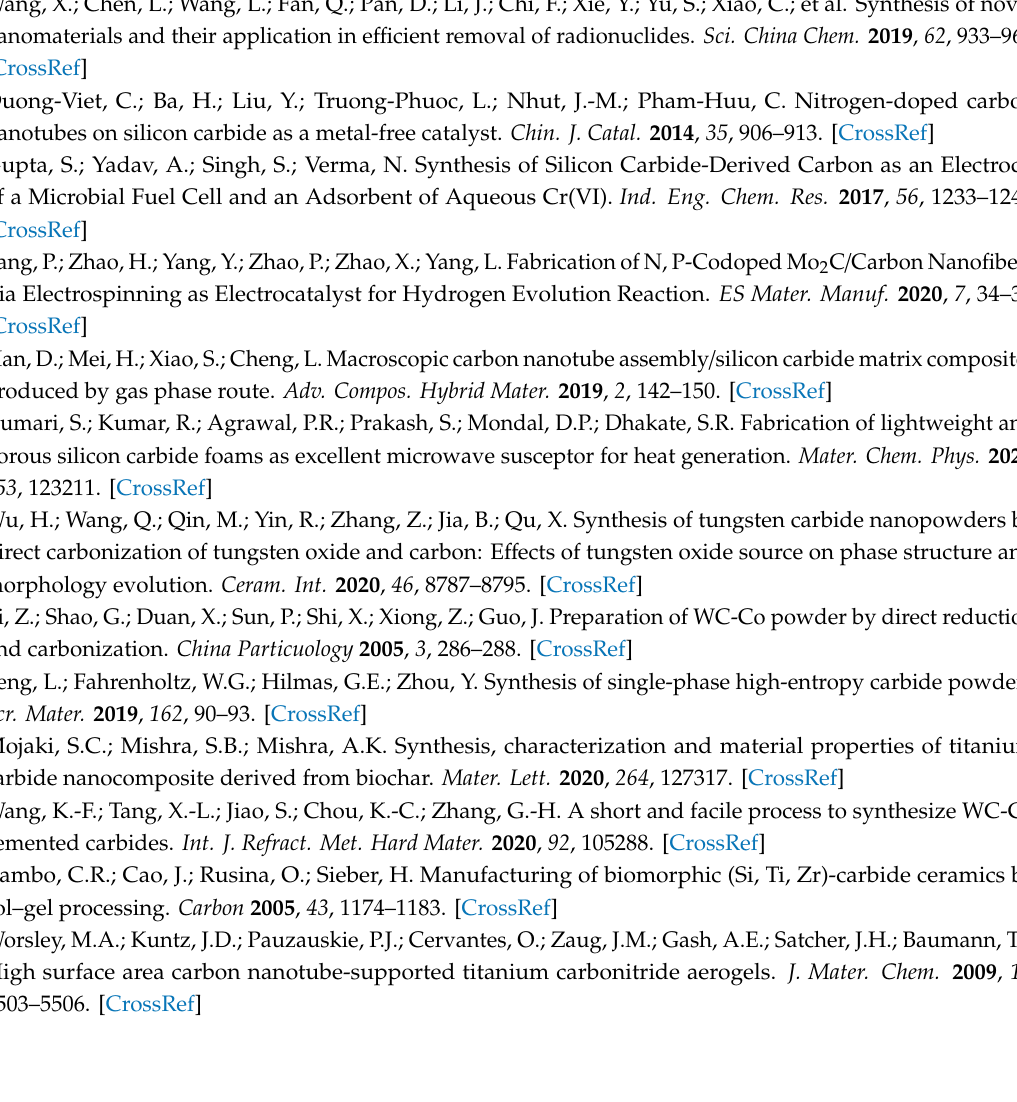
Figure S1: ( a ) The corrosion of C / TiO 2 aerogel with HF; ( b ) Raman spectrum, ( c ) SEM image, ( d ) EDX spectrum of C aerogel, Figure S2. The 1st derivative curves at the beginning ( a ) and the ending ( b ) of illumination within 1 s; ( c ) the comparisons of temperature variation within 54 s before the ending of illumination; ( d ) the di ff erence in temperature variation compared with C aerogel within 54 s before the ending of illumination, Video S1: The whole process of the temperature rise and the temperature